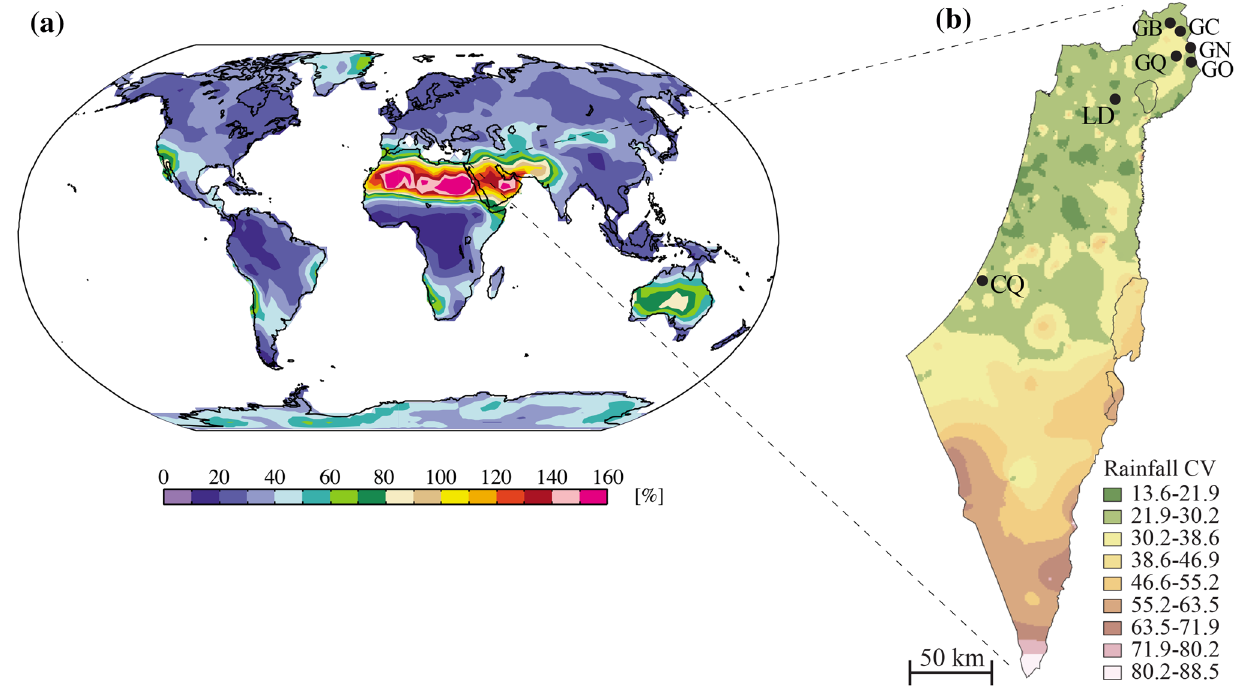
Figure 1. ( a ) Model for the global interannual variability in rainfall (CV; modified after Mahlstein et al. 23 ). All results are for the wet season. ( b ) Map of Israel denoting the seven vernal pools sampled in the study. The color patterns show the coefficient of variation (CV, %) in annual rainfall between the years 1999–2018. Rainfall data was obtained from the Israel Meteorological Service (IMS), and the annual rainfall variation layer was constructed using ArcGIS (version 10, ESRI Inc.). Pool name abbreviations were taken from Table